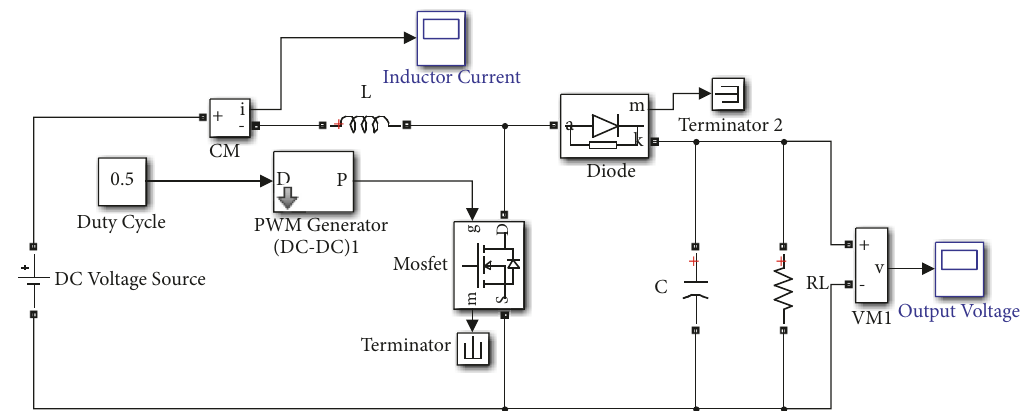
Figure 3: DC-DC boost converter.